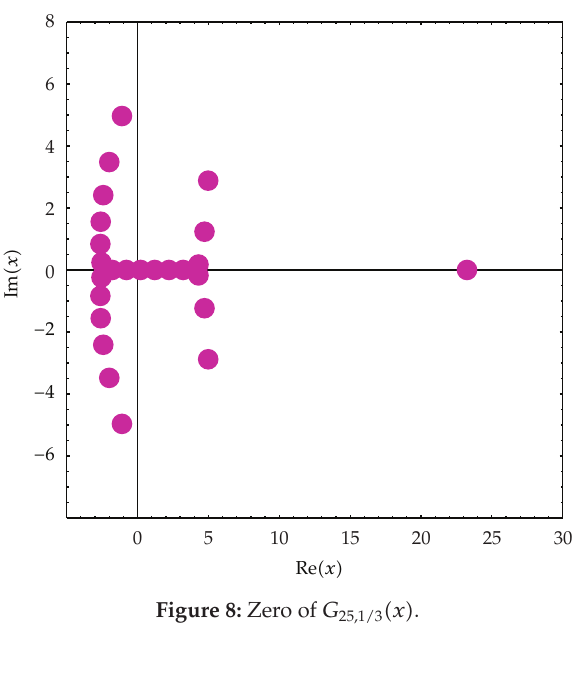
Figure 8: Zero of G 25 , 1 / 3 (cid:2) x (cid:3) .